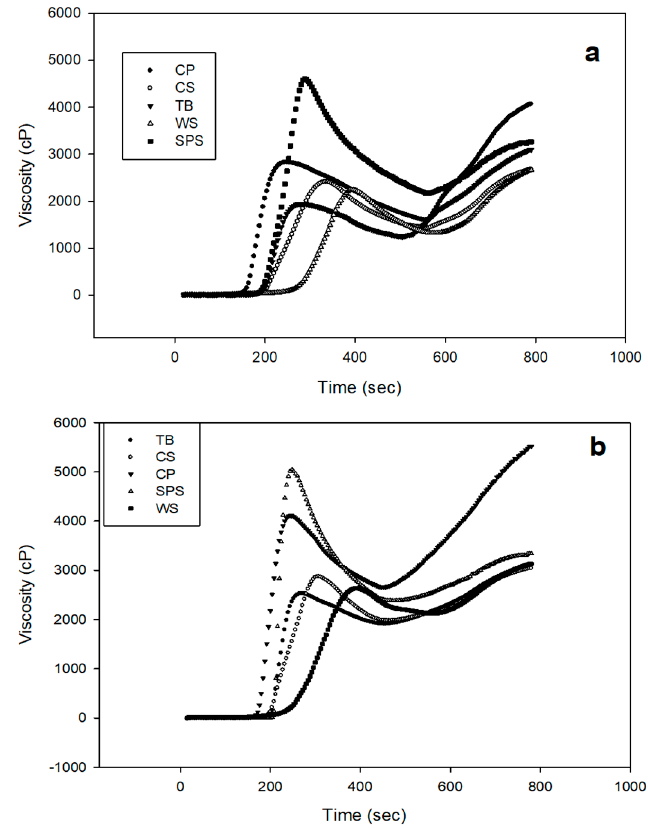
Figure 1. Viscosity profiles of Turkish bean (T.B.), corn (C.S.), chickpea (C.P.), sweet potato (S.P.S.) and wheat starches annealed at 50 °C for 20 min—( a ) native and ( b ) annealed. Table 1. The effect of germinated sorghum extract (GSE) on the peak viscosity (cP) of starches annealed at 40, 50, and 60 °C.